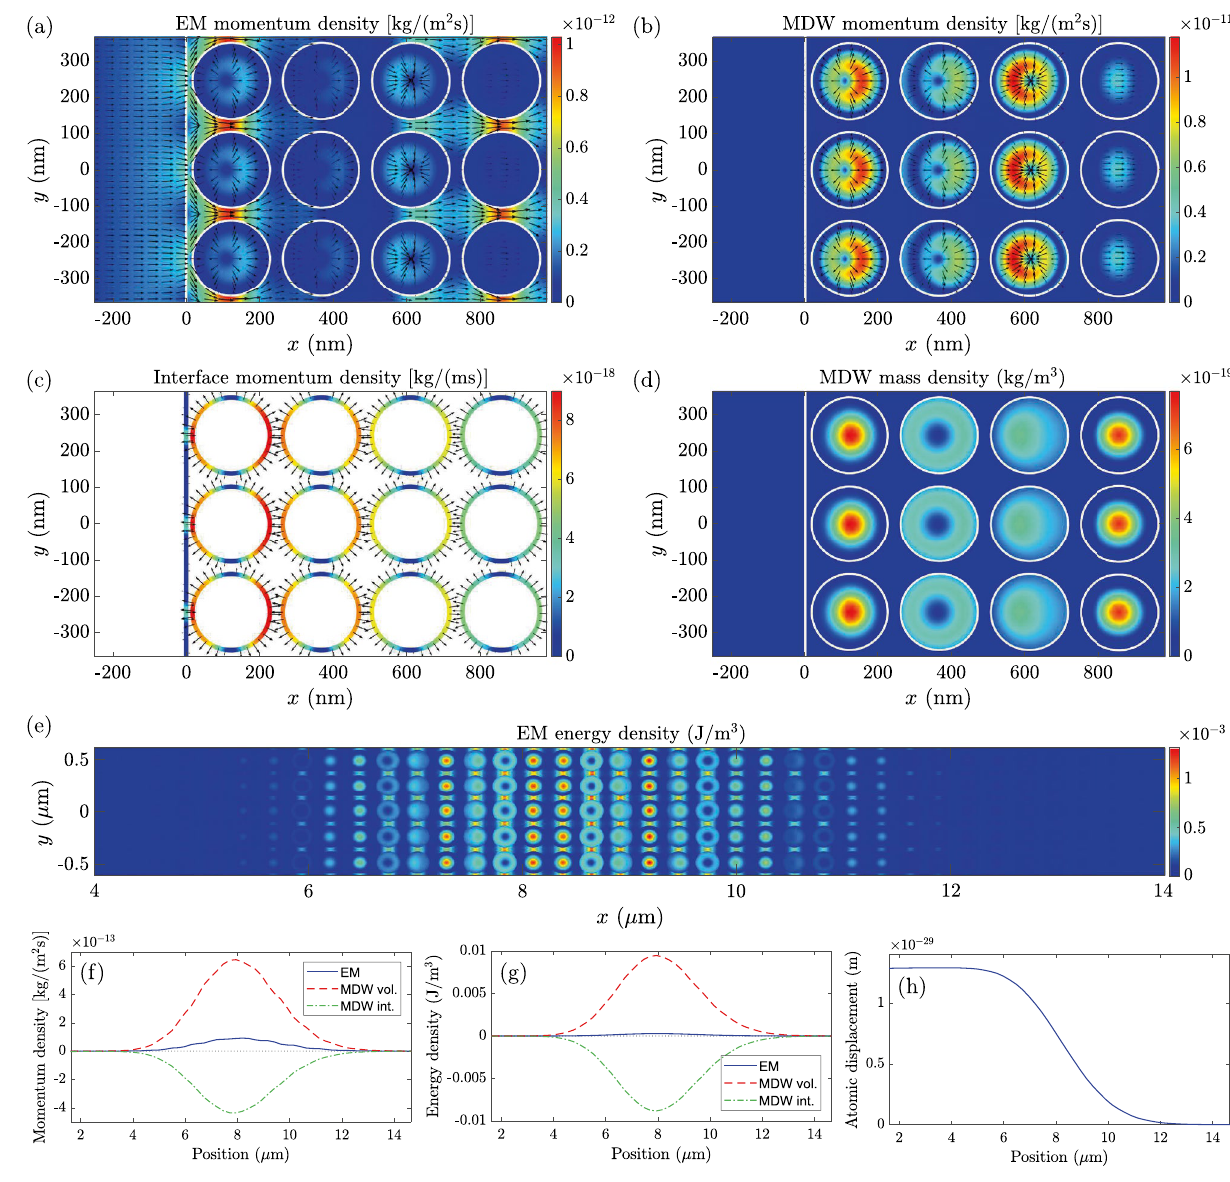
Figure 5. Simulation of light in an inhomogeneous NIM. The instantaneous ( a ) EM volume momentum density, ( b ) the atomic MDW volume momentum density, ( c ) the surface momentum density of interface atoms, and ( d ) the mass density of the atomic MDW as a function of position around the entry interface of the NIM structure. The snapshot is taken at the instance of time when the energy density maximum of the Gaussian light pulse incident from the left is at x = 0 . The linearly scaled color indicates the magnitude, and the logarithmically scaled arrows indicate the direction of the momentum densities. White solid lines depict material interfaces. ( e ) The EM energy density, ( f ) spatially averaged EM, MDW volume, and MDW internal interface momentum densities, ( g ) spatially averaged EM, MDW volume, and MDW internal interface energy densities, and ( h ) spatially averaged atomic displacement at an instance of time after the pulse has penetrated inside the